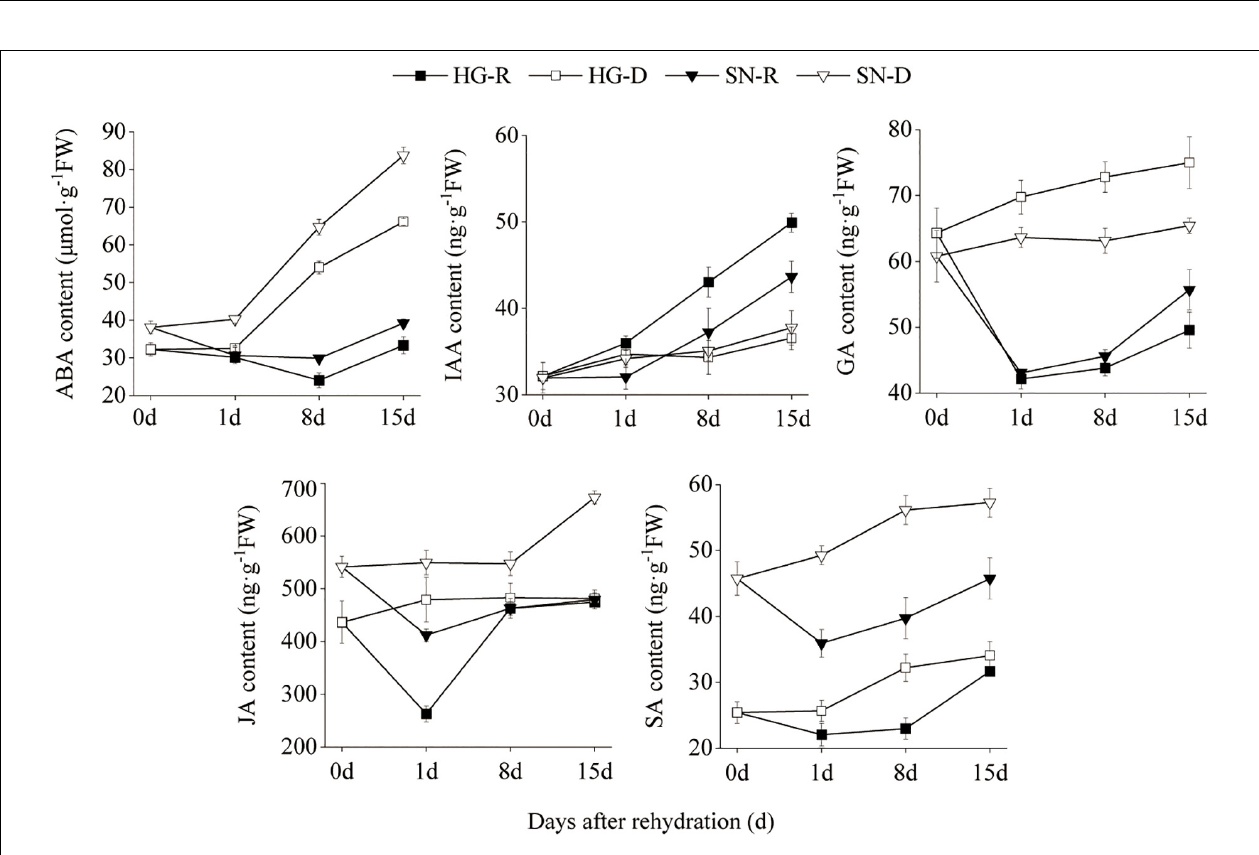
FIGURE 4 | The contents of phytohormones in HG and SN upon rehydration and continuous drought stress were evaluated using HPLC. The concentrations of ABA, IAA, GA, JA, and SA in both HG and SN leaves at 0, 1, 8, and 15 dpr were quantified.